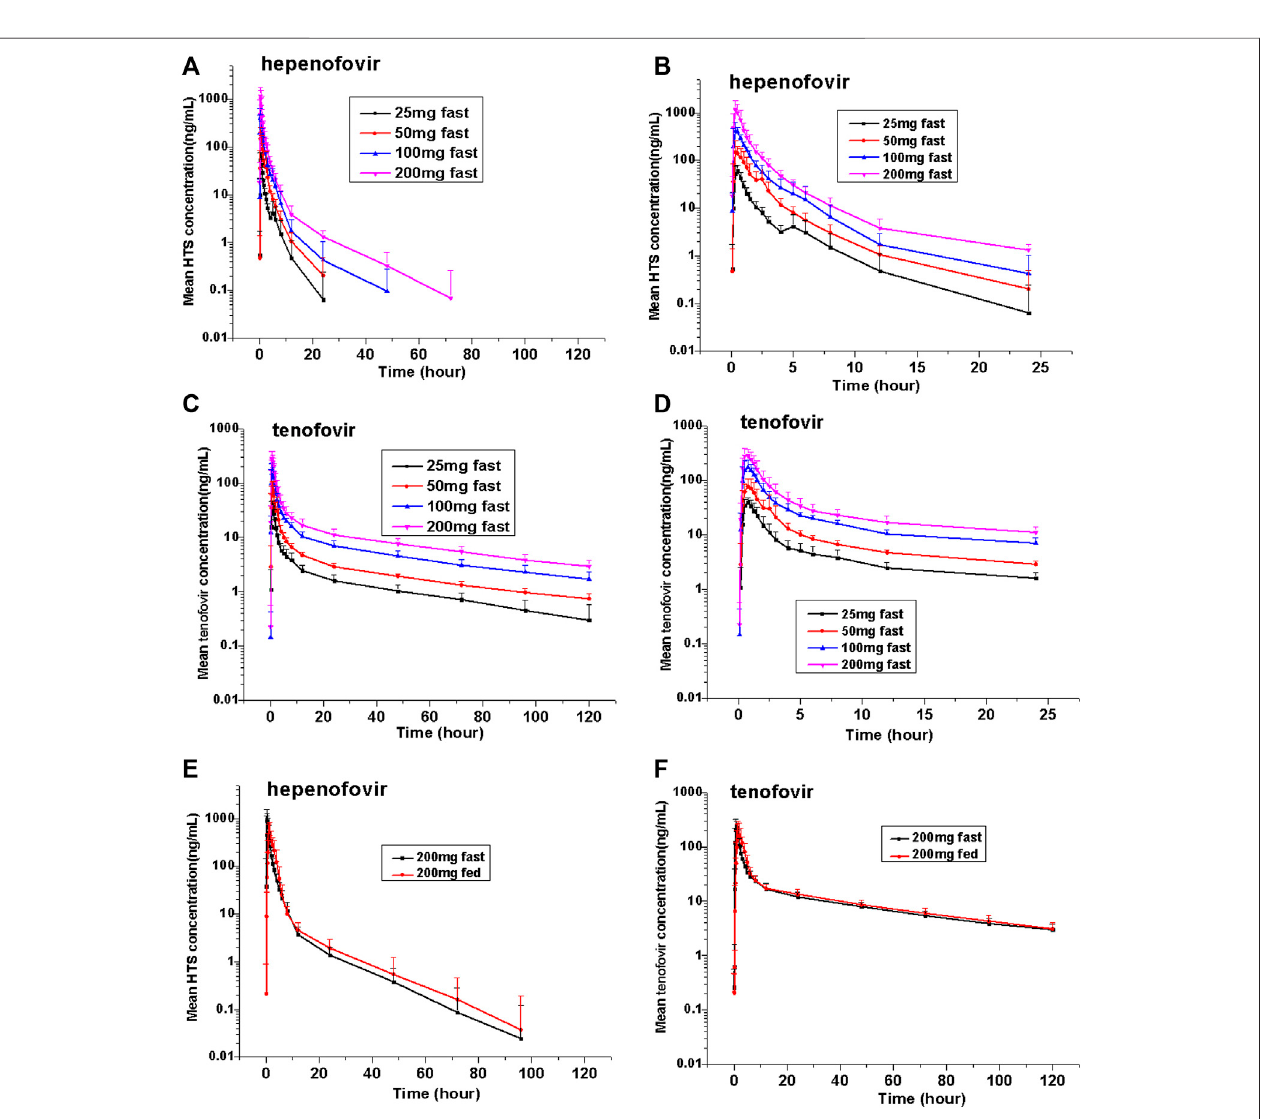
FIGURE 2 | Mean values of plasma hepenofovir and tenofovir concentration-time pro fi les in each treatment group for the single-ascending dose study and food effect study. Data illustrations included: mean (± standard deviation [SD]) hepenofovir plasma concentration-time pro fi les (A) and mean (±SD) hepenofovir plasma concentration-timeof0 – 24 h pro fi les (B) ; mean (±SD) tenofovir plasma concentration-time pro fi les (C) and mean(±S (D) tenofovir plasmaconcentration-time of0 – 24 h pro fi les (D) ;mean(±SD)hepenofovirplasmaconcentration-timepro fi lesofthefoodeffectstudy (E) ;mean(±SD)tenofovirplasmaconcentration-timepro fi lesofthe food effect study (F)